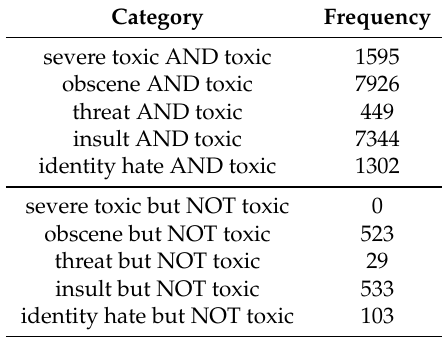
Table 2. A comparison of the occurrence and frequency of individual categories with the toxic